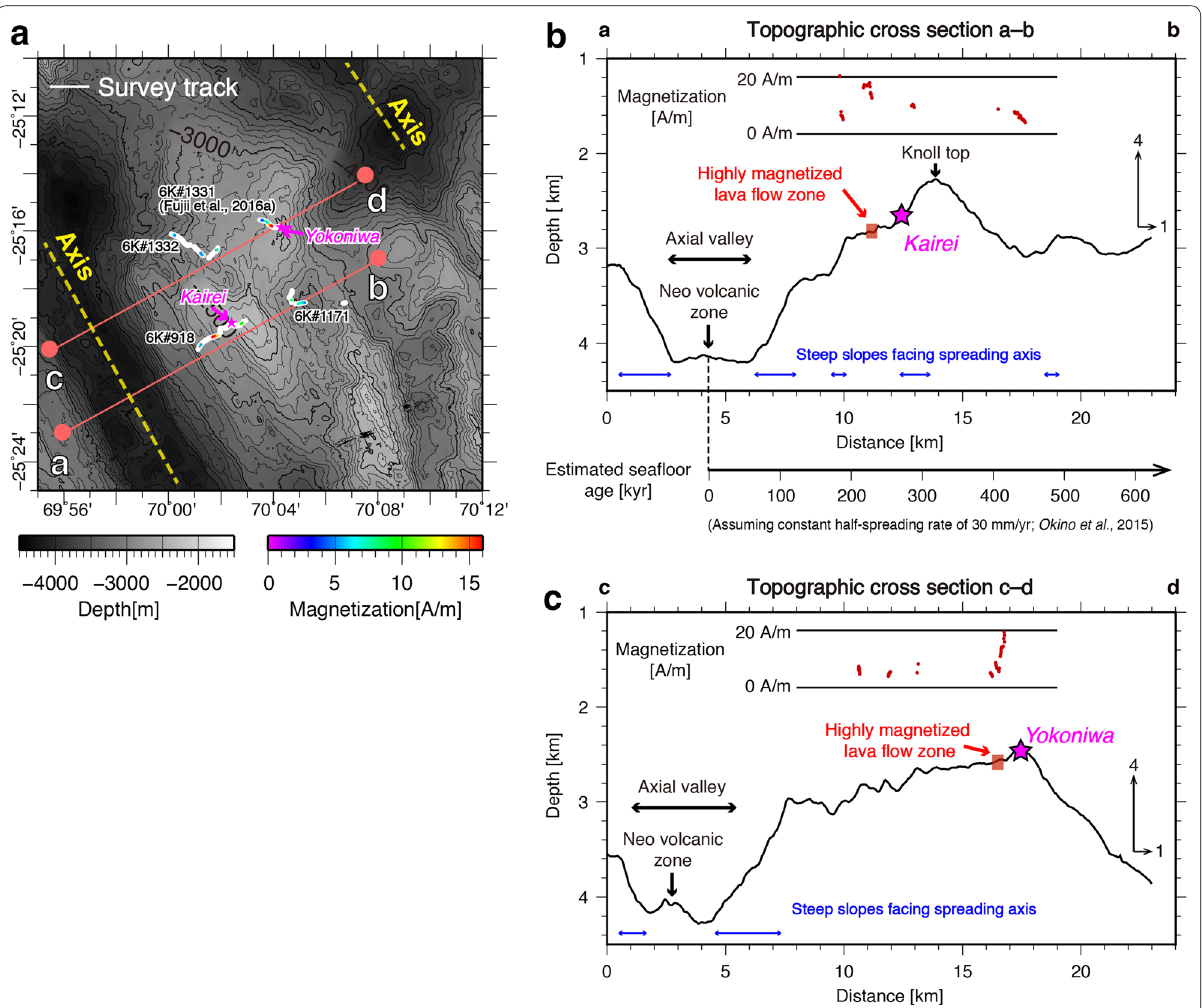
Fig. 7 Distribution of highly magnetized lava flows with normal polarity. a geographic distribution, b profile across the spreading axis to the off-axis area including the Kairei field, and c profile across the spreading axis to the off-axis area including the Yokoniwa field. Magnetization intensities of estimations with high coherency (> 0.5 in both x and z directions) and normal polarity (phase of from selected and shown as a rainbow-colored circle in ( a ) and as a black circle in ( b ) and ( c ). White circles in ( a ) show the observed area in which the estimation of absolute magnetization from magnetic anomaly was conducted. The raw data of magnetic anomaly along dive 6K#1331 are cited from Fujii et al.